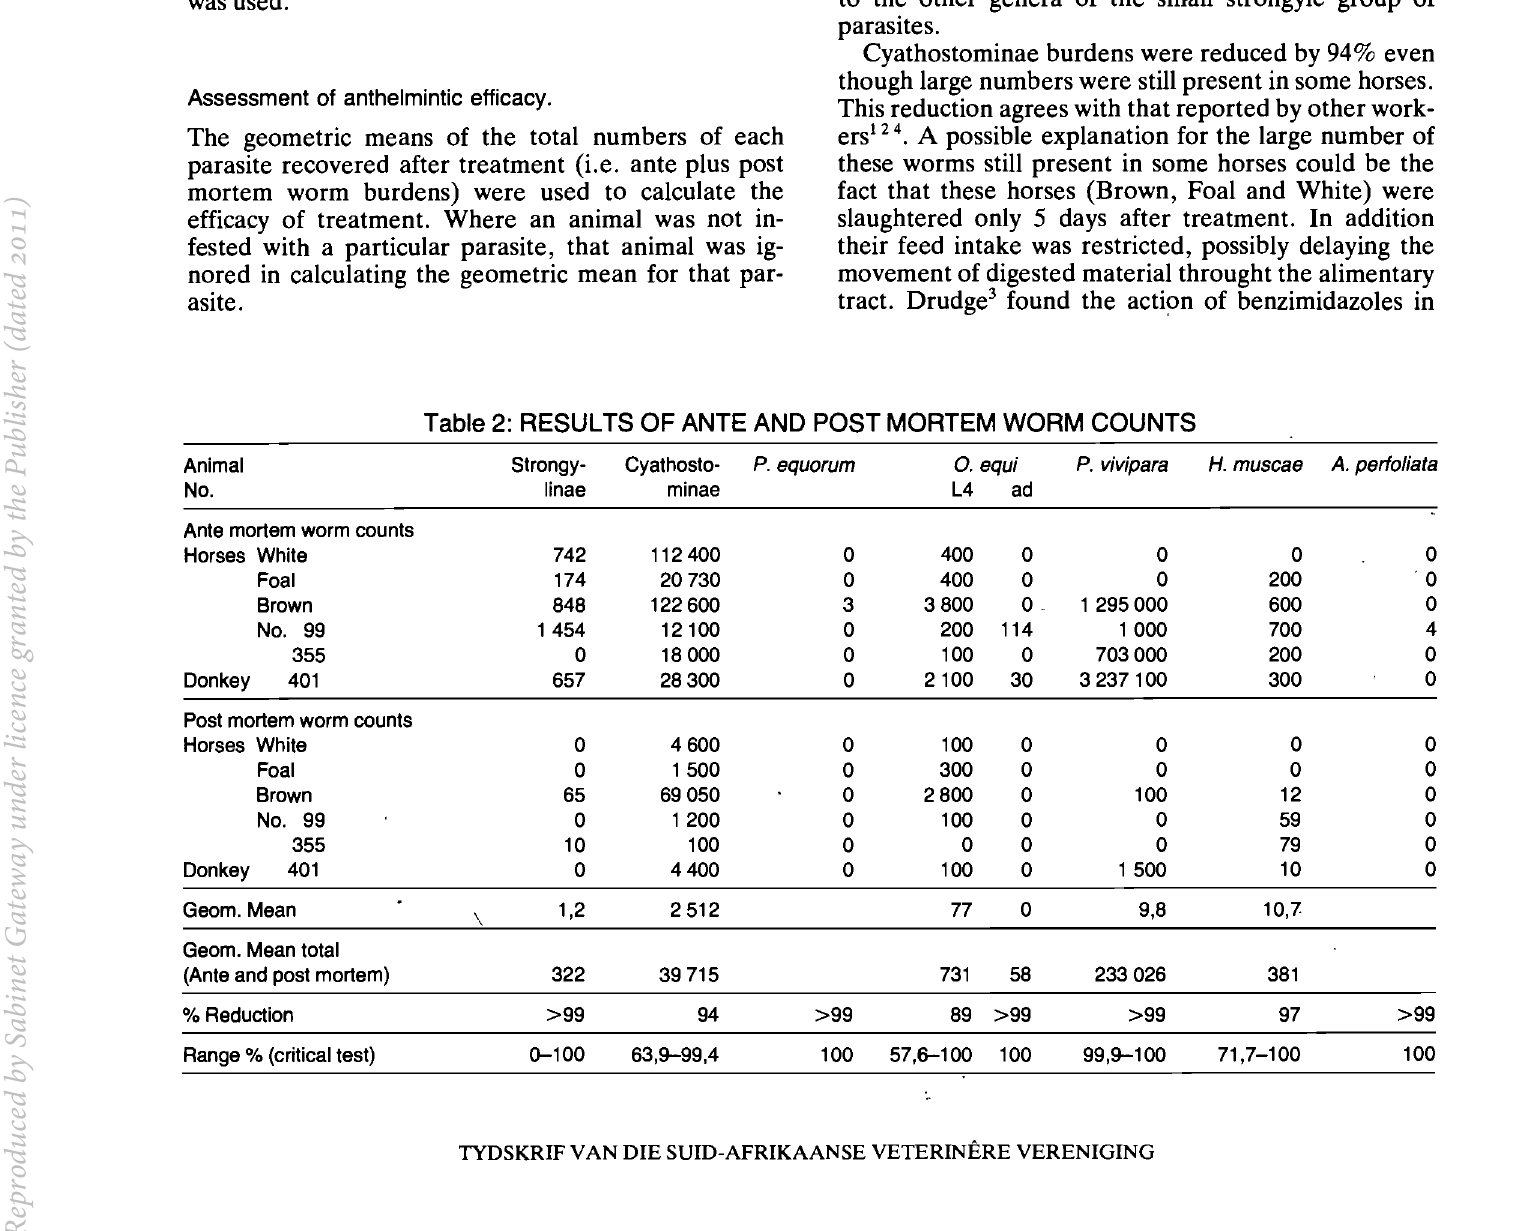
Table 2: RESULTS OF ANTE AND POST MORTEM WORM